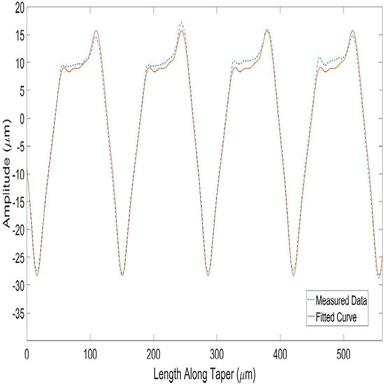
Computational approximation of microgroove topography from a RMM profile trace.